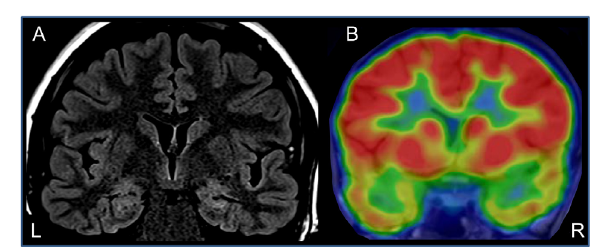
FIGURE 1 | Anatomical and functional neuroimaging – coronal sections through the temporal lobes. (A) T2-weighted FLAIR MRI showing right hippocampal hyperintensity. (B) Interictal brain PET-CT – showing bilateral hypo-metabolism in temporal lobes (right >>